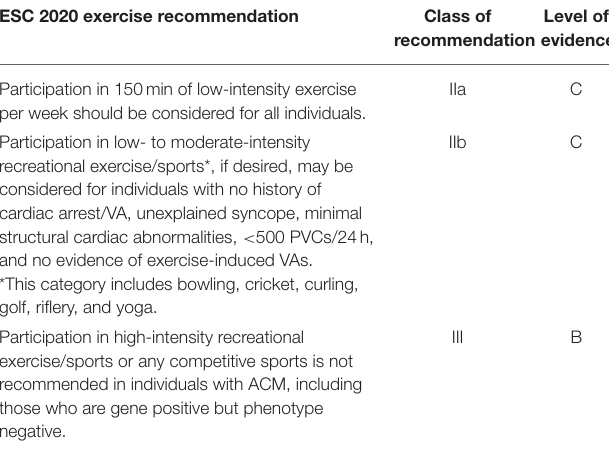
TABLE 2 | Modified exercise recommendations for patients with arrhythmogenic cardiomyopathy included in the European Society of Cardiology